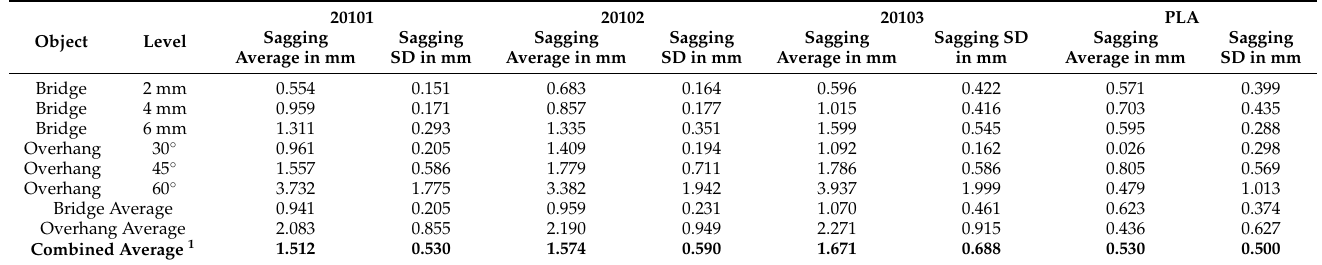
Table 5. Results from automatic profilometer measurements on the bridge and overhang specimens.